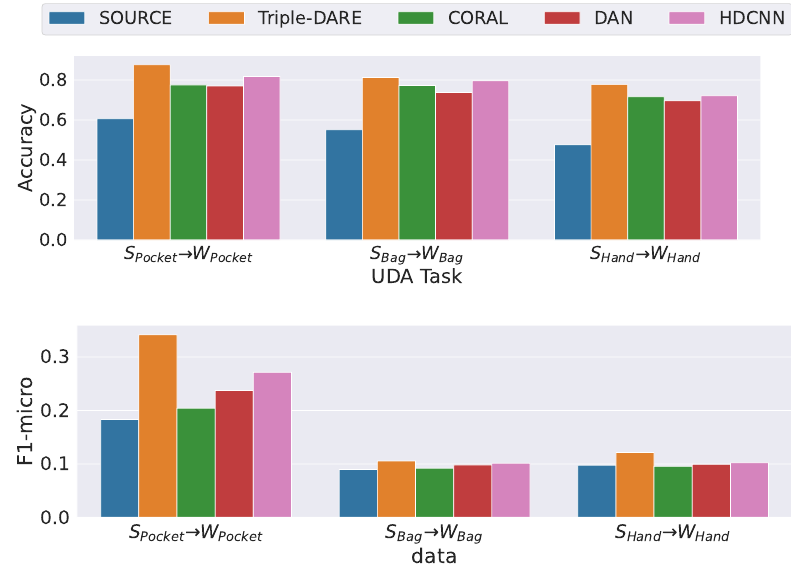
Figure 7. Scripted context to In-The Wild UDA tasks